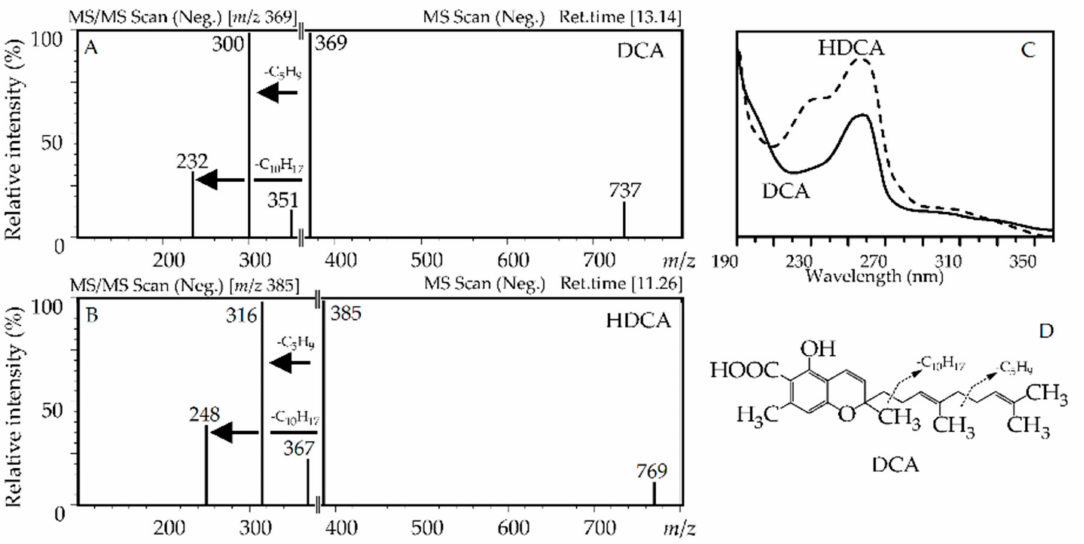
Figure 8. Mass spectra ( A , B ); negative ionization), UV patterns ( C ) of daurichromenic acid (DCA) and hydroxy- daurichromenic acid (HDCA), and fragmentation way of DCA ( D